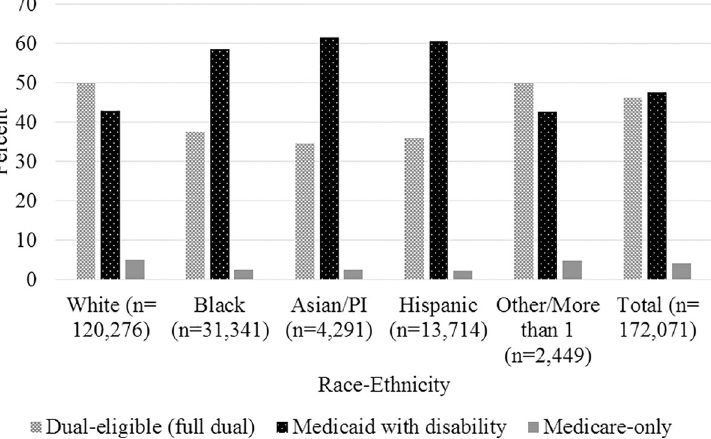
Fig 2. Percentage of beneficiaries eligible for Medicare, Medicaid, or full-dual status by race-ethnicity among adults with autism spectrum disorder.